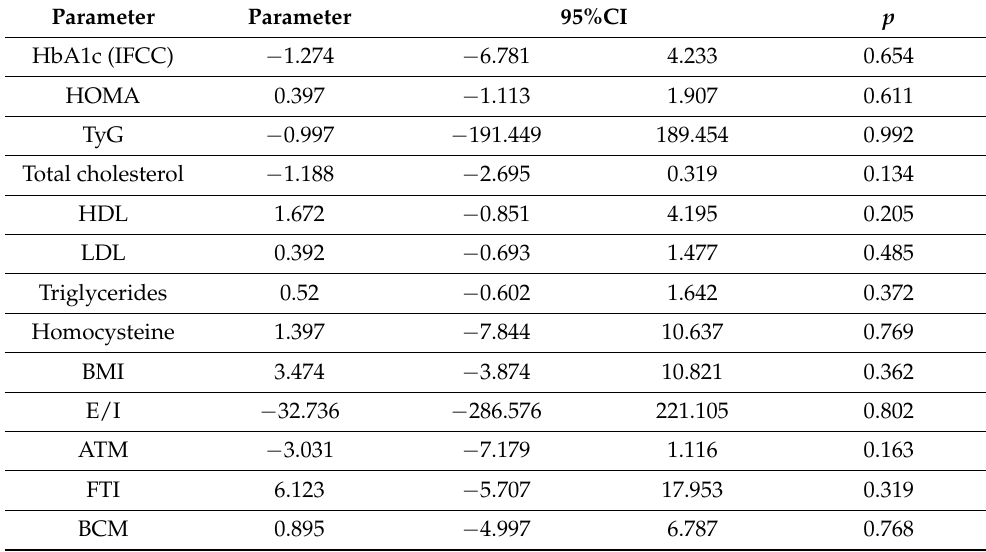
Table 7. Galectin-9 in urine after